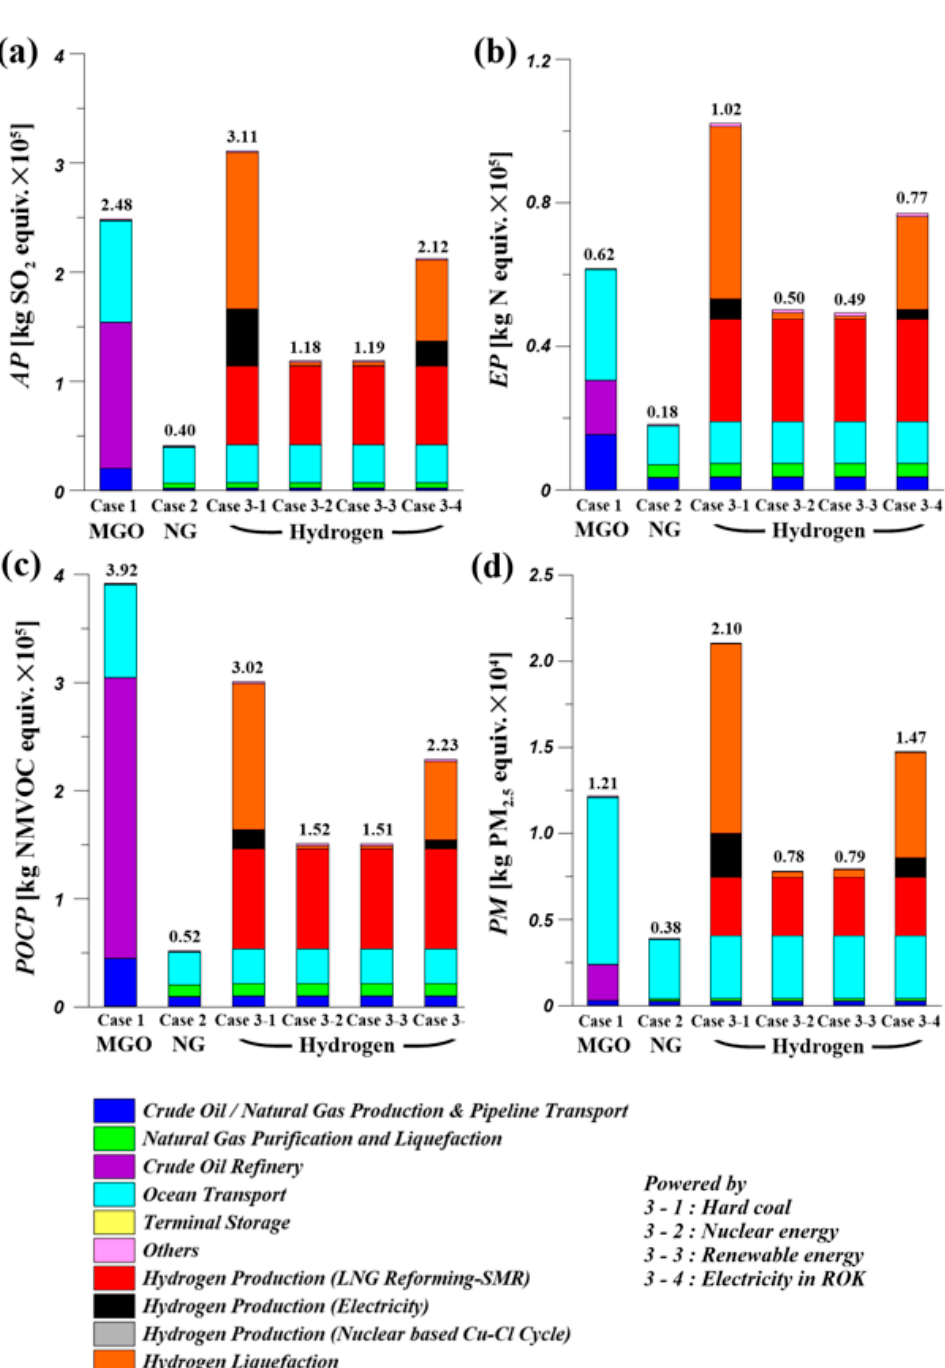
Figure 7. Acidification potential (AP), photochemical potential (POCP), eutrophication potential (EP), and particulate matter (PM) emissions at the Well-to-Tank phase: ( a ) AP; ( b ) EP; ( c ) POCP; and ( d ) PM.